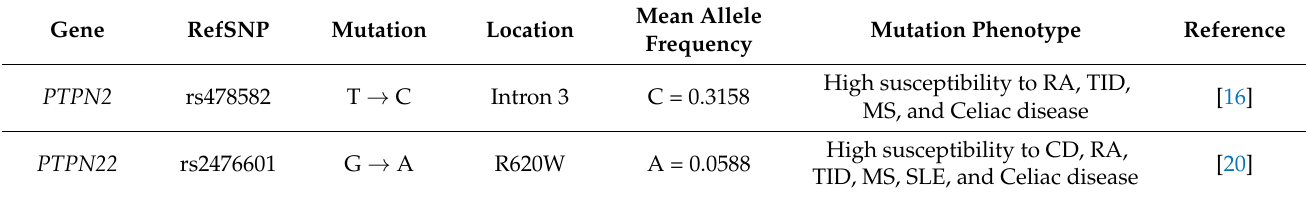
Table 1. List of SNPs examined in this